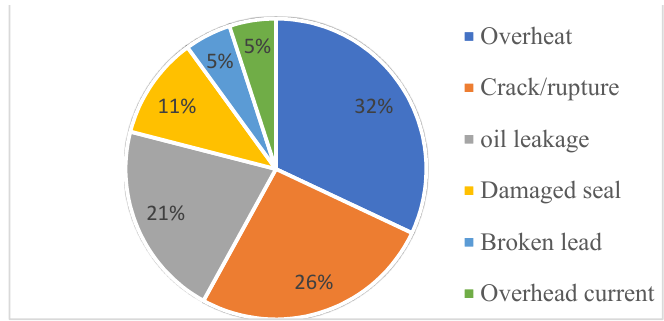
Figure 10. Outages due to bushing problems [65].